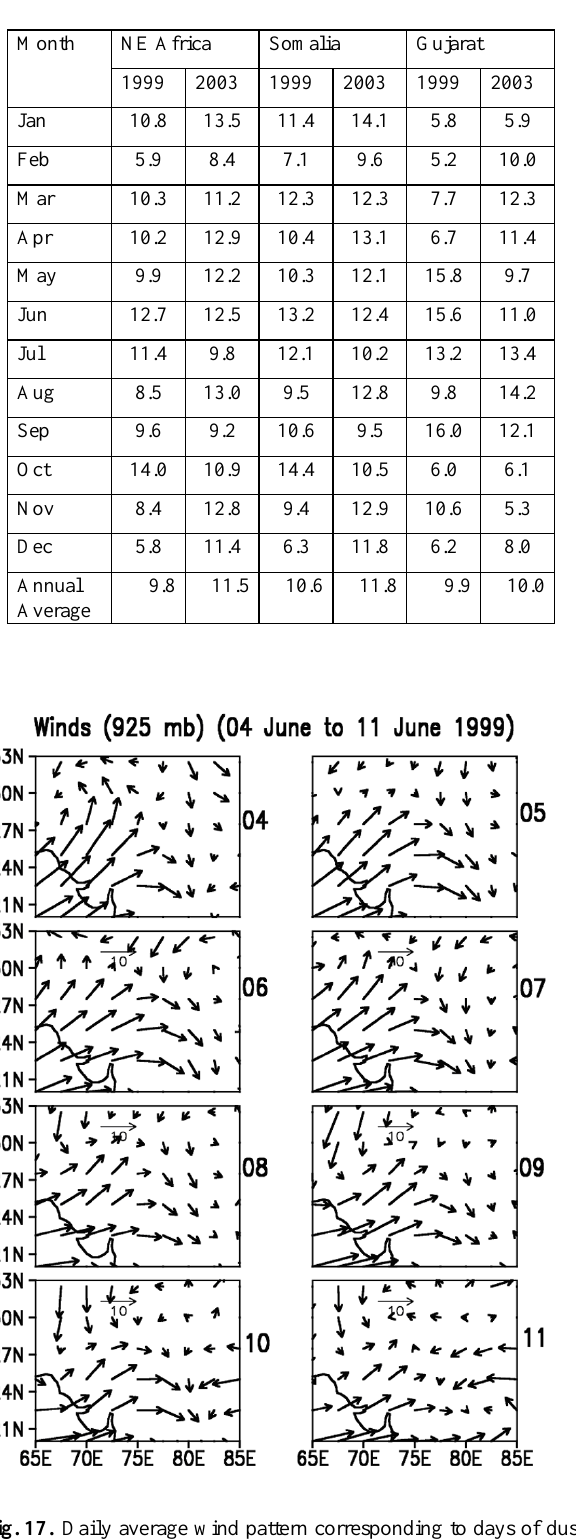
Fig. 17. Daily average wind pattern corresponding to days of dust storm shown in Fig. 13.